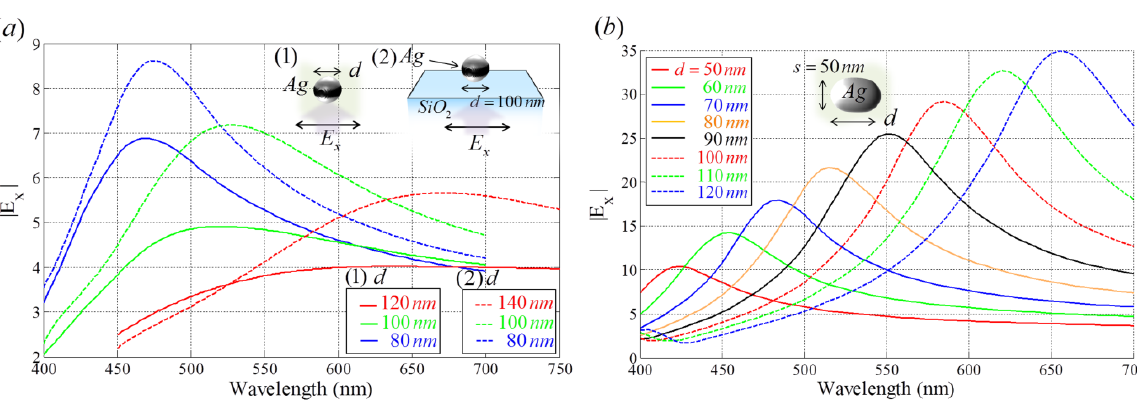
Figure 7. Spectra of enhanced E field of (a) Ag nanoparticles (1) without or (2) with a x substrate in aqueous solution (refractive index = 1.33) and (b) elliptical